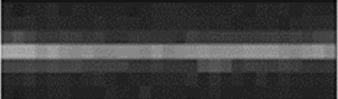
Figure 16. Line target in an image.